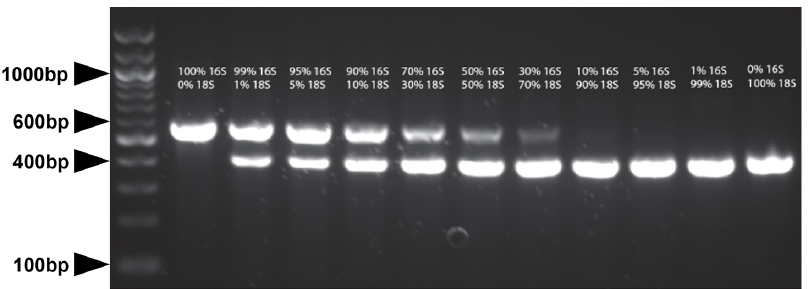
Figure 2. Assay Template Composition versus Relative Band Brightnesses for the Linearized Plasmid Mixture Series. The agarose gel shows the amplification of PCR products from a linearized plasmid-only assay series. The percentages given correspond to the percentage of the 2 m l DNA template volume that was comprised of 4 ng/ m l Marinomonas sp. 16S or D. grandis 18S target sequence-containing linearized plasmid. The relative intensity of the relevant band (550 bp for 16S, 400bp for 18S) is observed to vary according to the percentage of target sequence in the template DNA. It should be noted that the percentages quoted concern weight per volume, however the differences in product sizes (400 bp vs. 550 bp) mean that the molar ratios (i.e. number of DNA molecules) are 1.375:1 18S:16S by concentration. The 100 bp ladder (Invitrogen) is shown in the first lane with the 1000 bp, 600 bp, 400 bp and 100 bp markers noted.